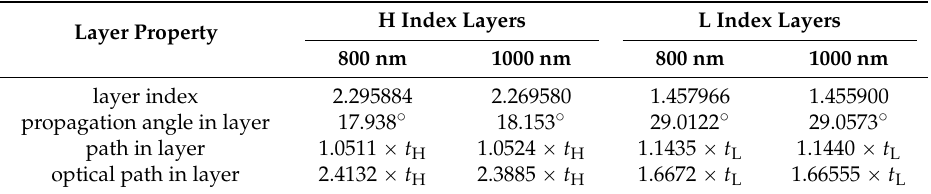
Table 3. Examples, for TiO 2 (H index) and SiO 2 (L index) layers, of variations in layer